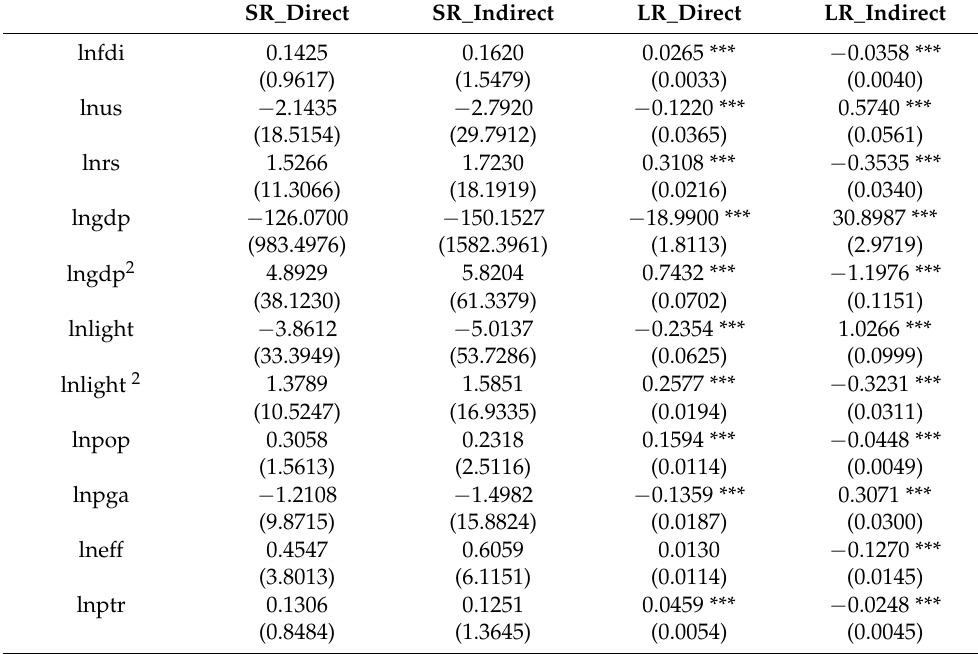
Table 6. Decomposition of effects in the dynamic SDM